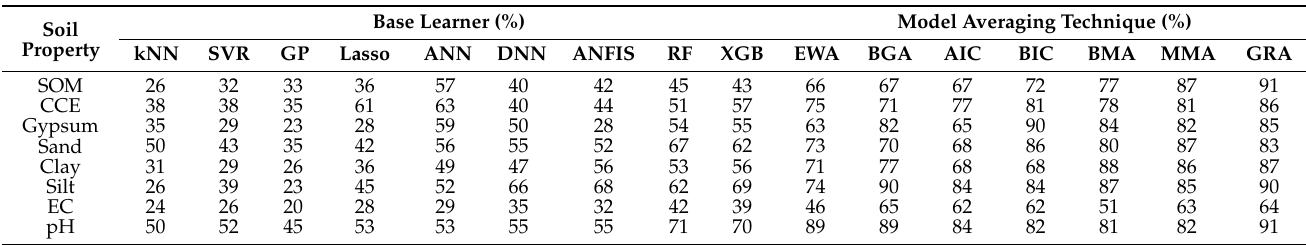
Table 4. Uncertainty of the models for predicting soil properties (prediction interval coverage probability; PICP).